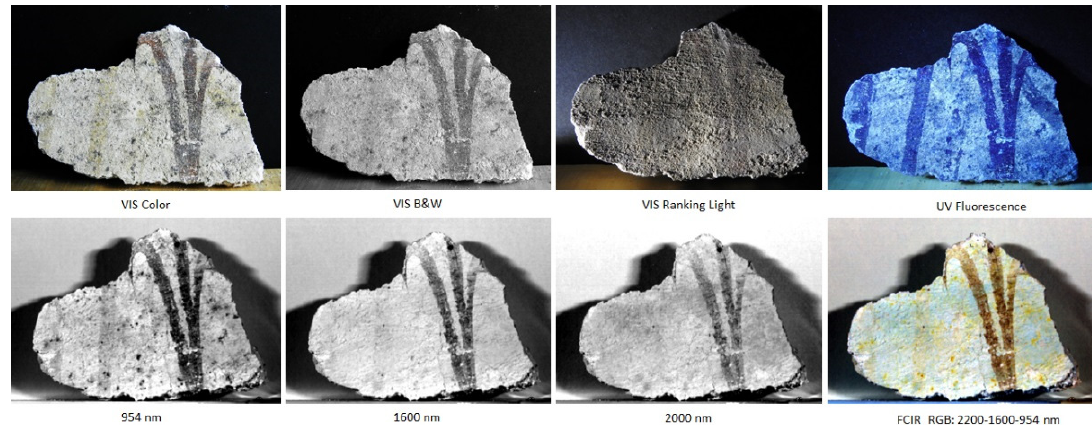
Figure 10. Imaging documentation obtained on a wall painting fragment from Ulpia Traiana Sarmizegetusa.